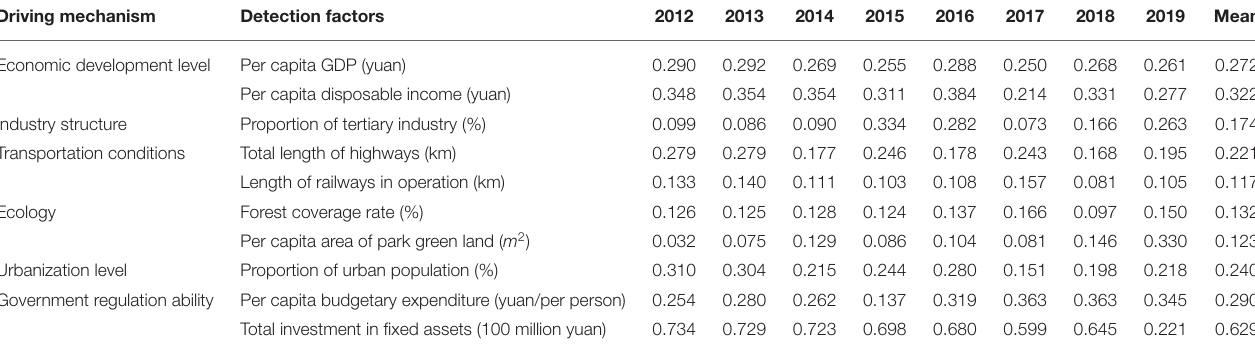
TABLE 5 | Driving factors affecting coupling and coordination between tourism development and medical services ( q